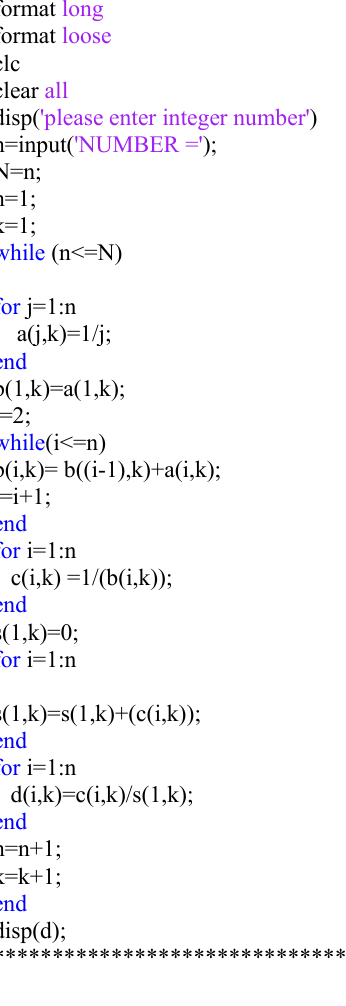
%% In this code, column 2 of d matrix corresponds to n=2, column 3 of d matrix corresponds to n=3,…, and column 15 of d matrix corresponds to